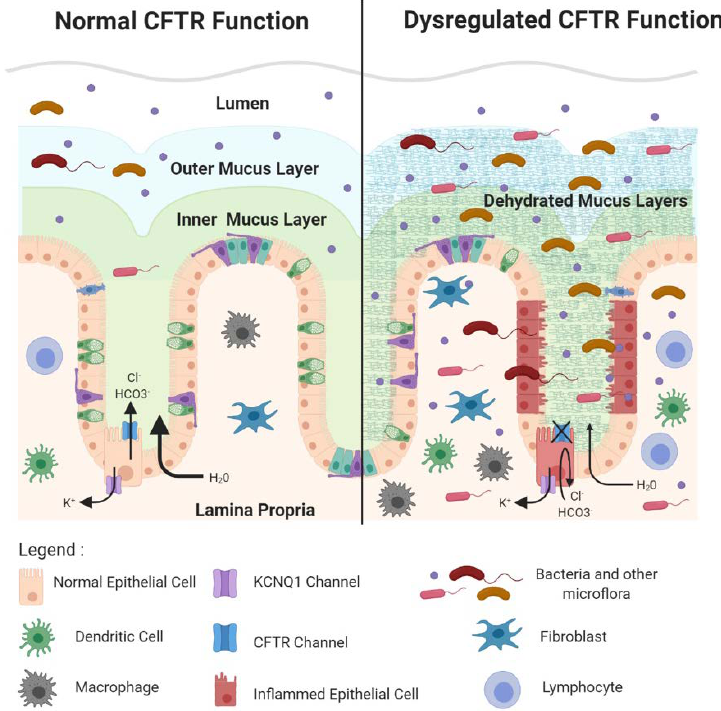
Figure 2. CFTR deficiency disrupts protective physical barriers and leads to dysbiosis. CFTR deficiency causes a failure of intestinal cell chloride and bicarbonate ion e ffl ux and accompanying water e ffl ux. This results in dehydration of the mucus layer, making it permissive to bacterial passage, and also causing intestinal obstruction. Disruption of the epithelial barrier leads to infiltration of commensal and pathogenic bacteria, inflammation, epithelial tissue damage, and immune cell infiltration. These alterations in the intestinal landscape (mutations, inflammatory signaling) create favorable conditions for CRC initiation and progression. Figure created using BioRender.com.